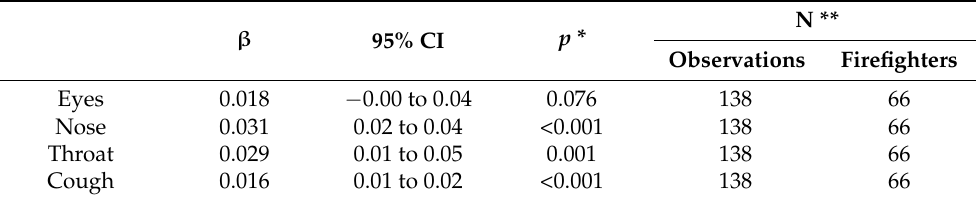
Table 8. Relation of estimated hours fire fighting since the start of the season to the extent to which symptoms were bothersome at the start of